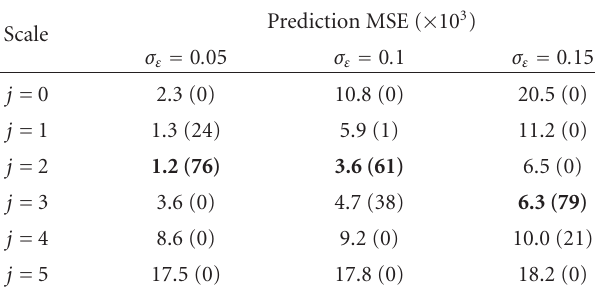
Table 2: Comparison between the prediction means square errors at multiple